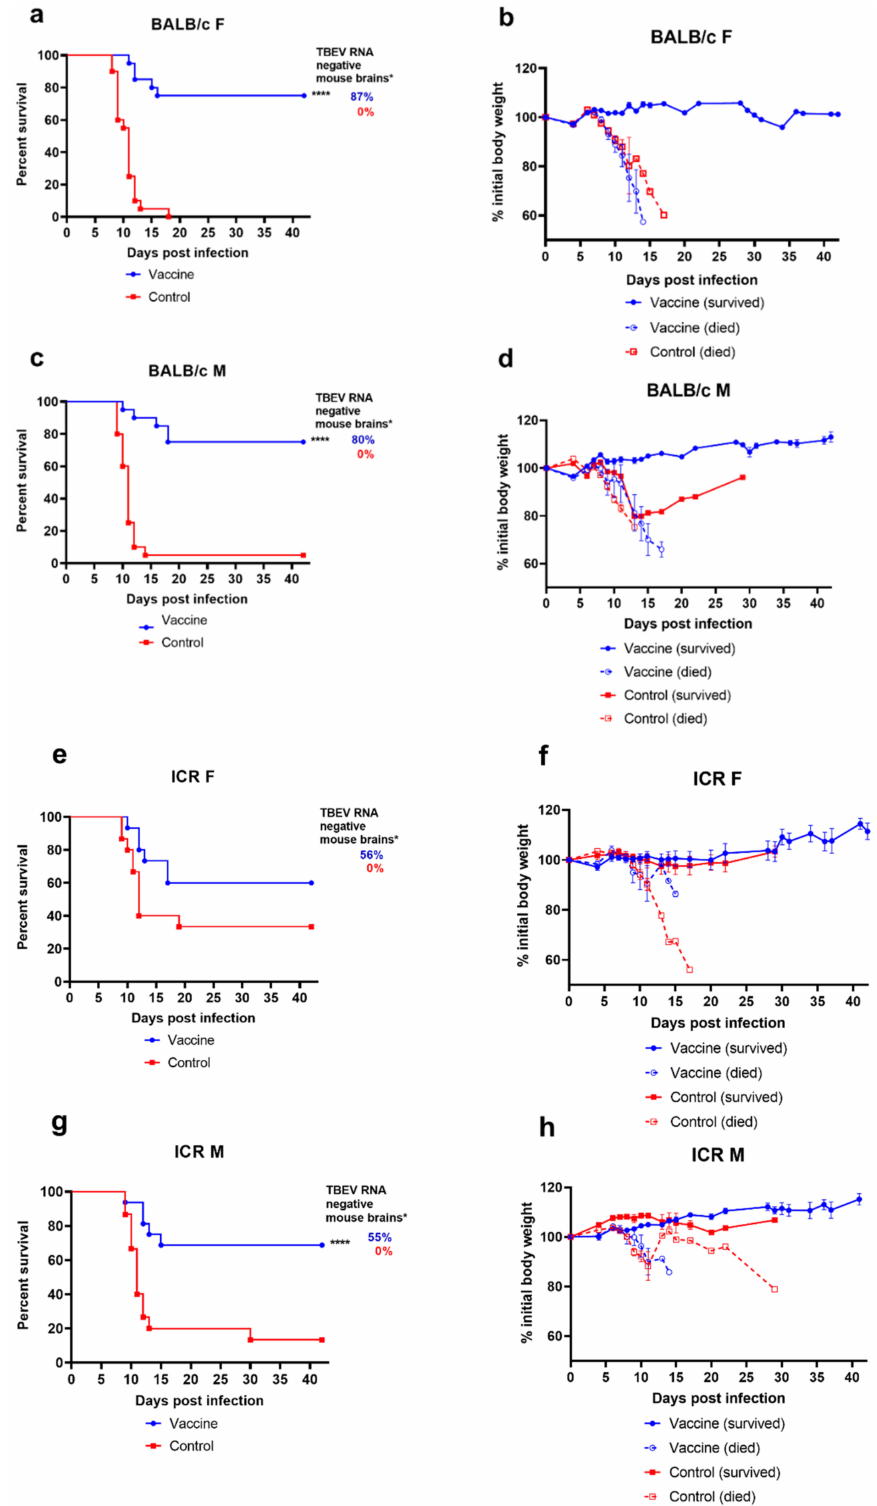
Figure 1. Survival and weight changes in BALB/c and ICR mice vaccinated with TBE vaccine Tick-E-Vac after challenge with 300 PFU/animal of TBEV strain Vasilchenko. ( a , b ) female BALB/c mice (n = 20 per group), ( e , f ) female ICR mice (n = 15 per group), ( c , d ) male BALB/c mice (n = 20 per group), ( g , h ) male ICR mice (n = 16 for vaccine group, n = 15 for control group). Animals were monitored for mortality ( a , c , e , g ), weight loss ( b , d , f , h ), and disease symptoms (data not shown) for 42 days after challenge. Error bars represent SEM. * All brain samples from dead mice were considered RNA-positive. Statistical significance for mortality data was determined by log rank test (**** p <